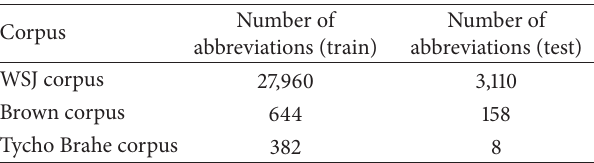
Table 3: Number of abbreviations in